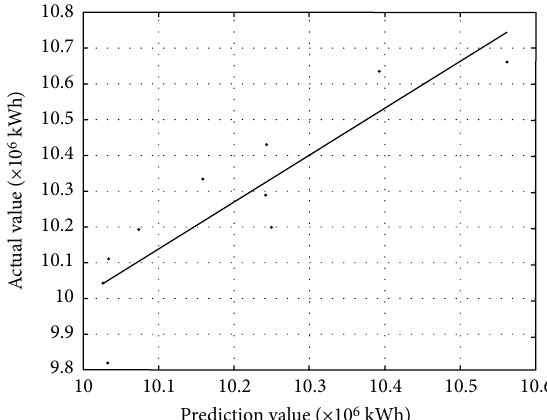
Figure 7: The regression curve of predicted values.